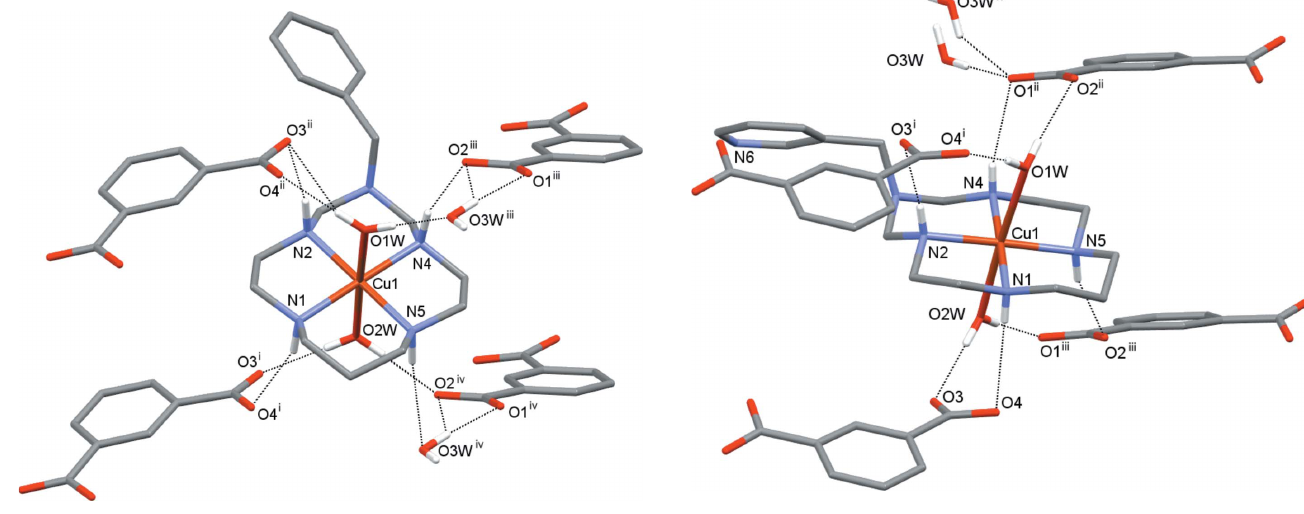
Figure 3 Nearest surrounding of the macrocyclic cation in (I) formed by hydrogen bonding (dashed lines). [Symmetry codes: (i) x – 1, y + 1, z ; (ii) x , y + 1, z ; (iii) – x + 3 , y + 1 , – z + 3 ; (iv) – x + 1 , y + 1 , – z + 3 .] 2 2 2 2 2 2